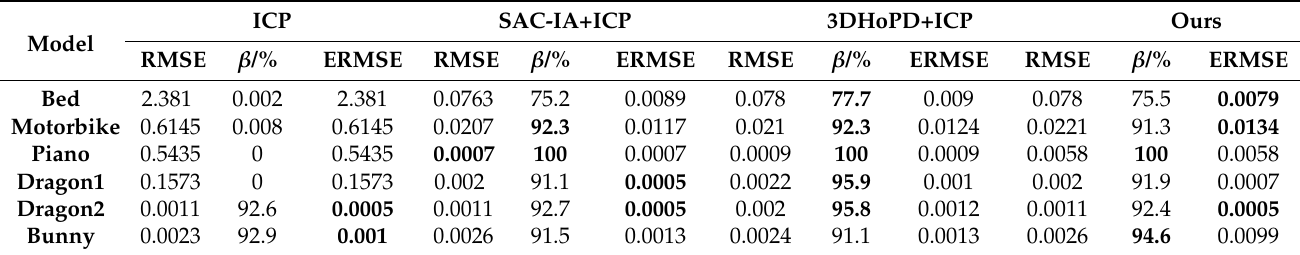
Table 5. RMSE, β , and ERMSE of ICP, SAC-IA+ICP, 3DHoPD+ICP, and our method for the six models.